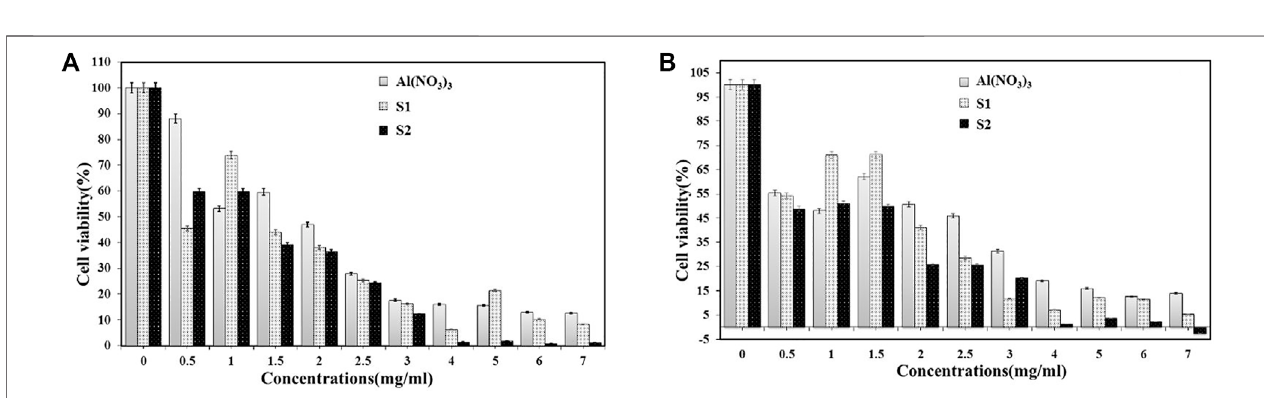
FIGURE8| Thecytotoxicityofvariousconcentrationsofherbalextractionandsamplesagainsthumanbreastcancercellsafterincubationfor (A) 24 hand (B) 48